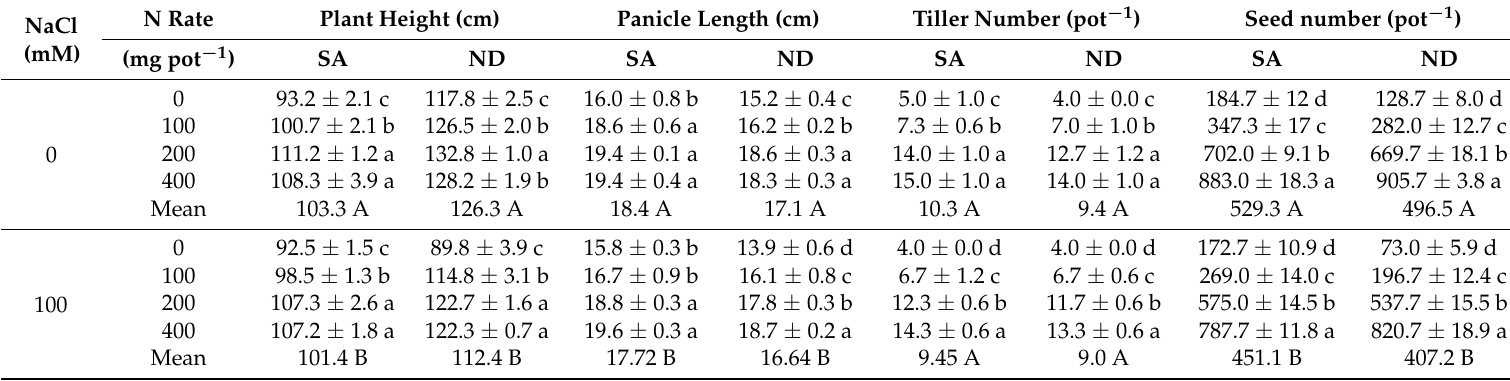
Table 12. Effects of salinity and nitrogen rate on plant height (cm) and yield components of the two oat genotypes (SA vs. ND) in the second run of a controlled greenhouse